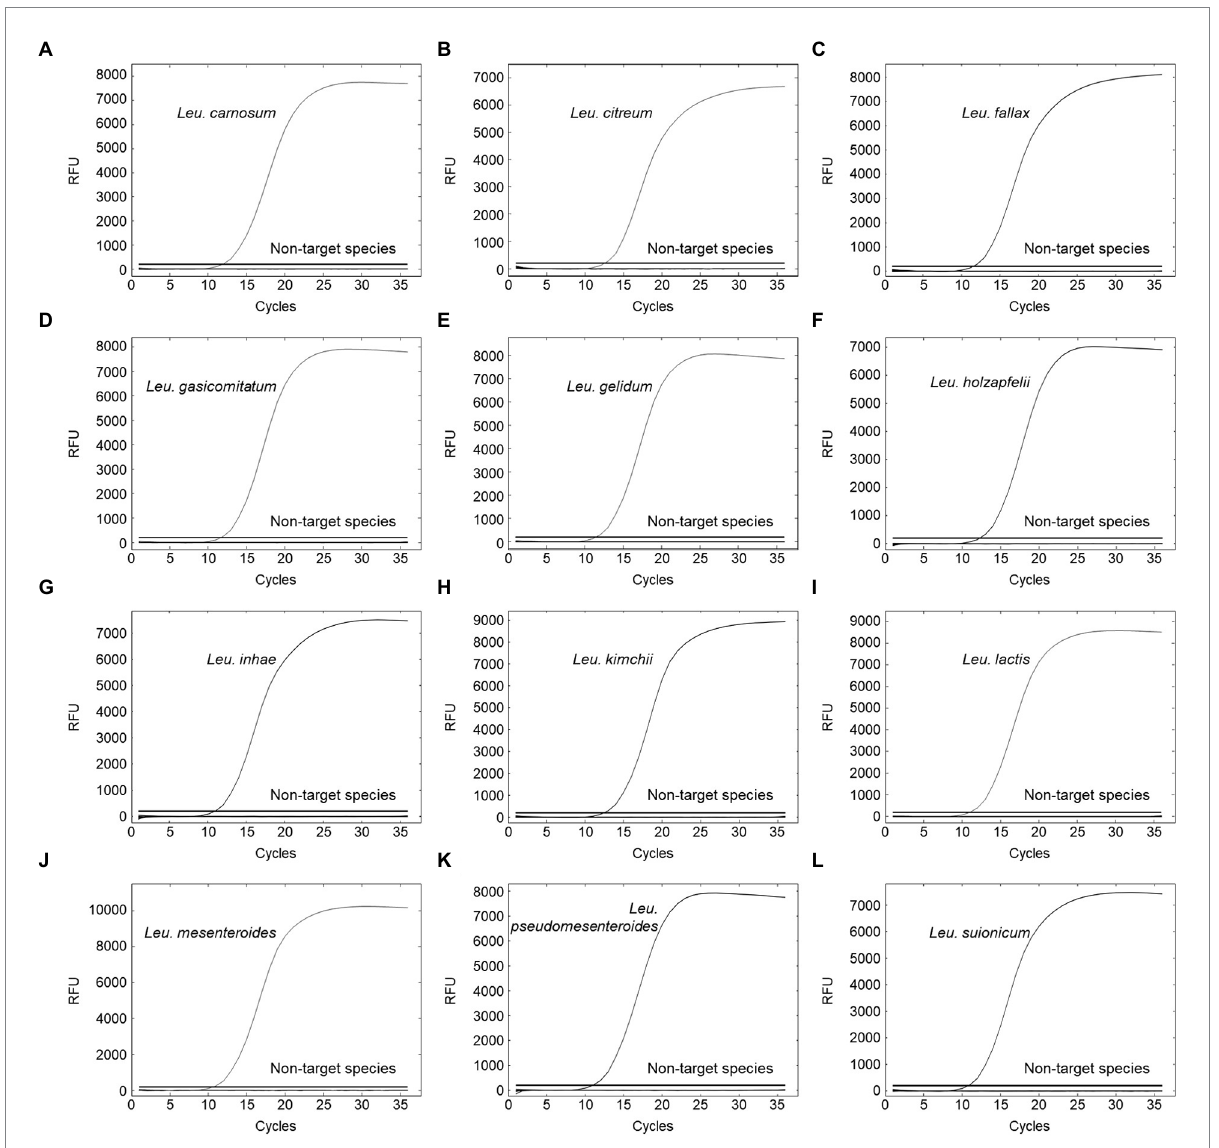
FIGURE 3 Specificity evaluation for (A) Leu . carnosum primer pair, (B) Leu . citreum primer pair, (C) Leu . fallax primer pair, (D) Leu . gasicomitatum primer pair, (E) Leu . gelidum primer pair, (F) Leu . holzapfelii primer pair, (G) Leu . inhae primer pair, (H) Leu . kimchii primer pair, (I) Leu . lactis primer pair, (J) Leu . mesenteroides primer pair, (K) Leu . pseudomesenteroides primer pair, and (L) Leu . suionicum primer pair. Test samples comprised 23 target strains of Leuconostoc species and 124 non-target